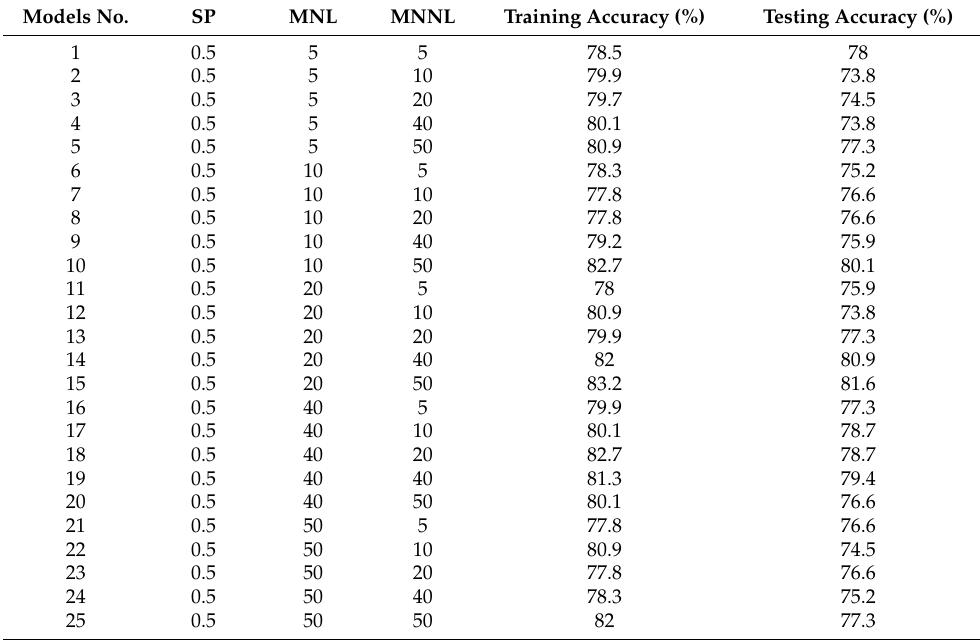
Table 4. The accuracies of training and testing of models based on the various control parameters.